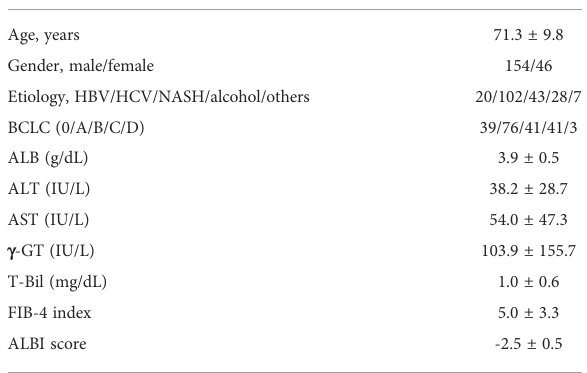
TABLE 2 HCC Patient